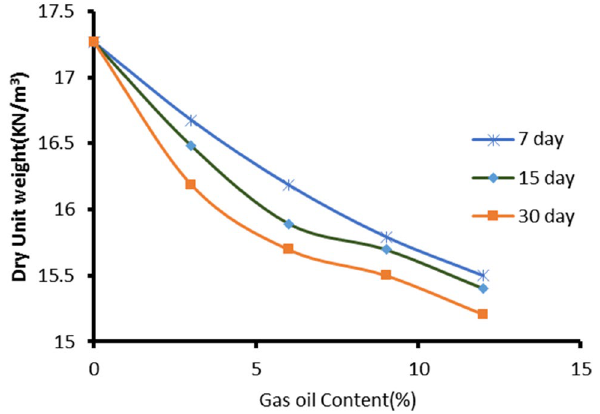
Fig. 12 Maximum dry density changes in 15-day contamination and different percentages of gasoline